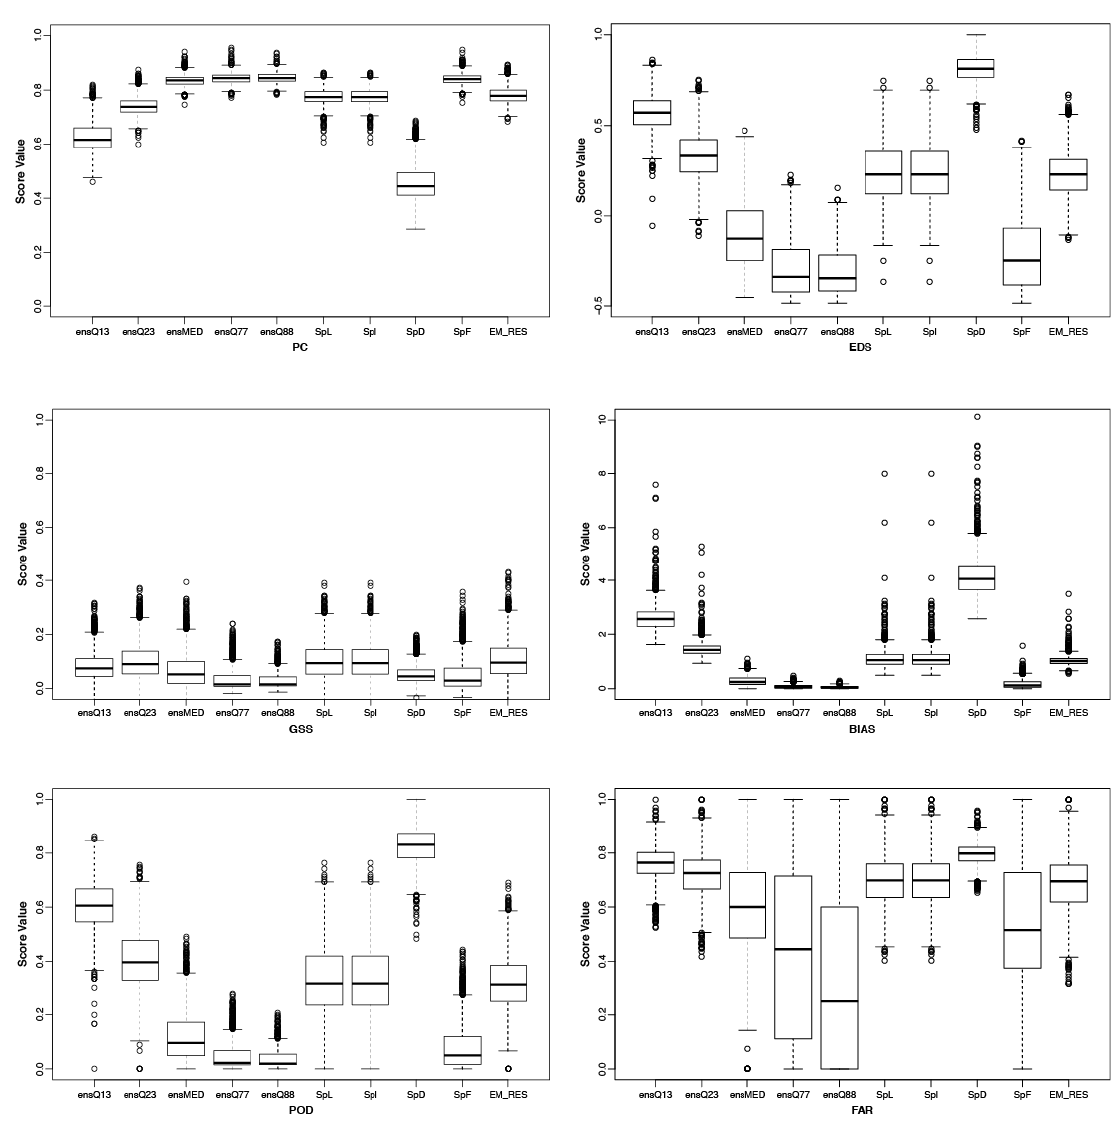
Figure 5. Verification measures of categorical drought forecasts (i.e., below the SPI3 “-1” threshold) estimated with the methods described in Table A2.